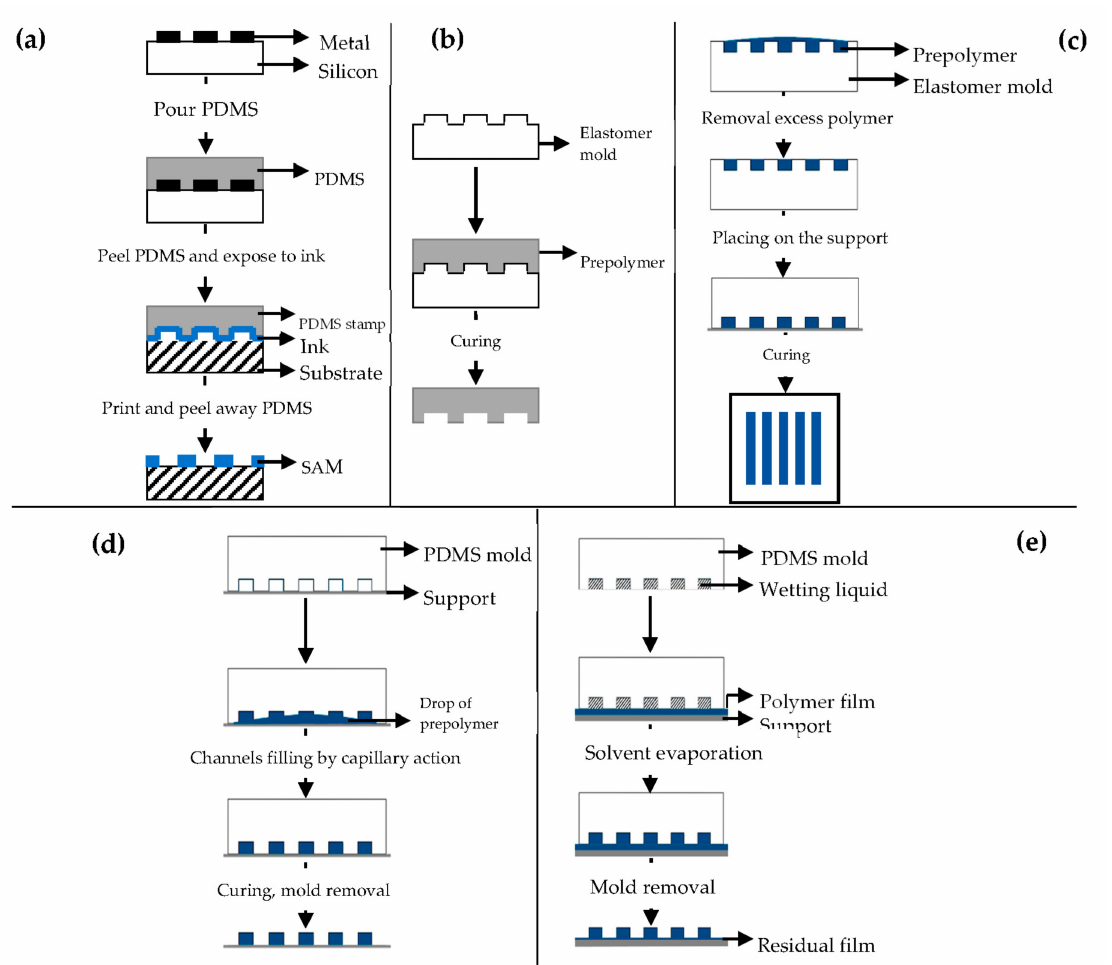
Figure 7. Schematic illustration of: ( a ) microcontact printing ( µ CP); ( b ) replica molding (REM); ( c ) microtransfer molding ( µ TM); ( d ) micromolding in capillaries (MIMIC); ( e ) solvent-assisted micromolding (SAMIM). Modified from [99,101]. CC BY